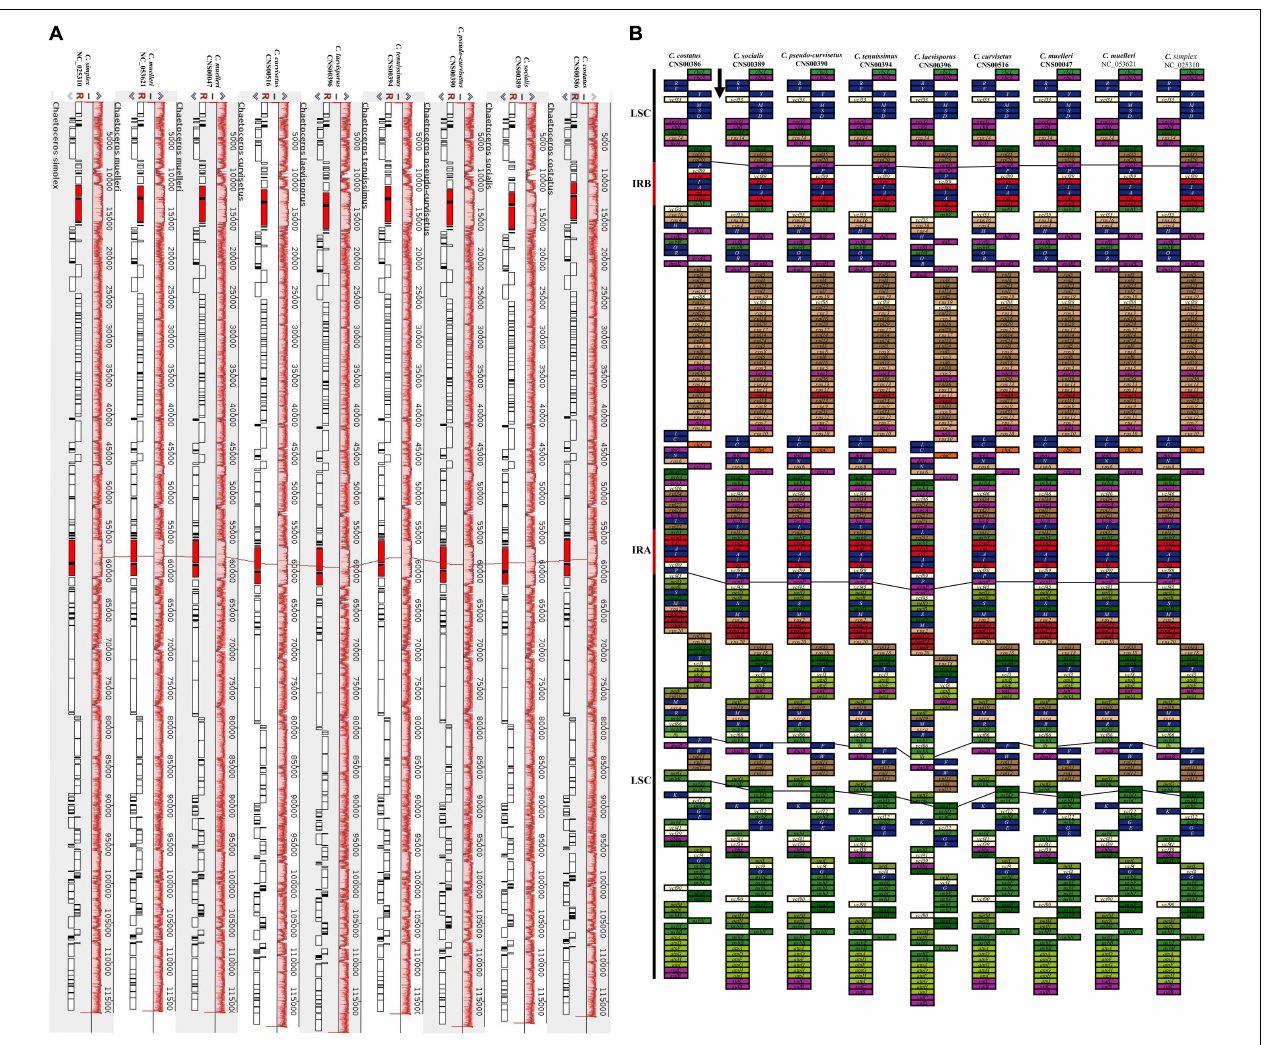
FIGURE 4 | Synteny relationships and gene arrangements of Chaetoceros. (A) Synteny relationships among Chaetoceros cpDNAs. (B) Gene arrangements of Chaetoceros species. Blocks with the same color represent the same type of genes. The black arrow indicates transcription